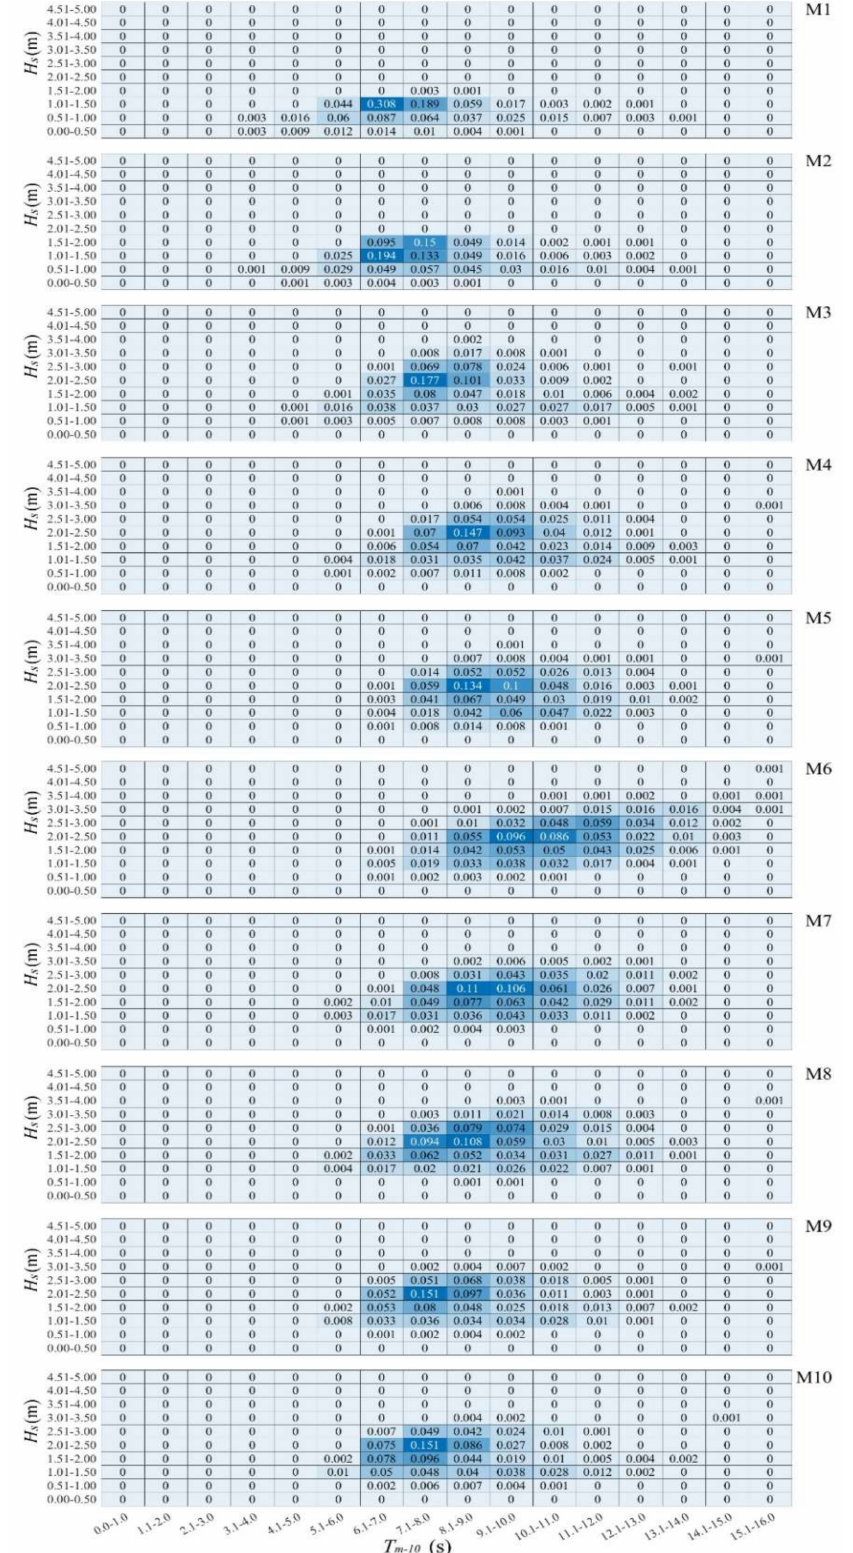
Figure 14. Scatter diagram of available wave power at locations M1–M10 under “present” climate scenario. The power is given as a fraction of available power in each sea state to total power available at the selected